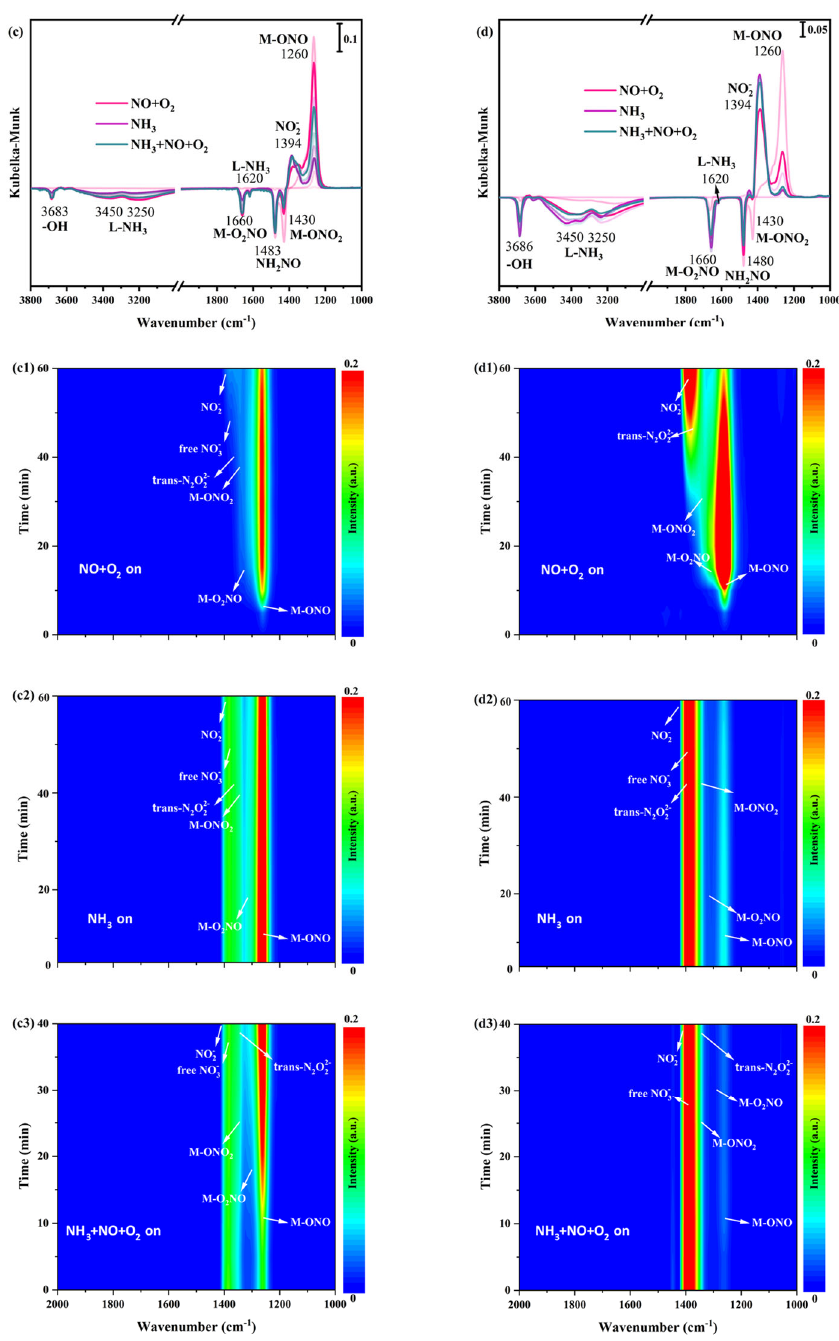
Figure 6. In situ DRIFTS spectra of NO+O 2 adsorption at 200 °C over ( a1 ) α -MnO 2 /X, ( b1 ) β -MnO 2 /X, ( c1 ) γ -MnO 2 /X, and ( d1 ) σ -MnO 2 /X catalysts; in situ DRIFTS spectra of NH 3 reacted with pre-ad- sorbed NO+O 2 species at 200 °C over ( a2 ) α -MnO 2 /X, ( b2 ) β -MnO 2 /X, ( c2 ) γ -MnO 2 /X, and ( d2 ) σ -MnO 2 /X catalysts; in situ DRIFTS spectra of NO+O 2 +NH 3 species at 200 °C over ( a3 ) α -MnO 2 /X, ( b3 ) β -MnO 2 /X, ( c3 ) γ -MnO 2 /X, and ( d3 ) σ -MnO 2 /X catalysts; the summary of in situ DRIFTS spectra of NO+O 2 adsorption, NH 3 reacted with pre-adsorbed NO+O 2 species, and NH 3 +NO+O 2 species at 200 °C over ( a ) α -MnO 2 /X, ( b ) β -MnO 2 /X, ( c ) γ -MnO 2 /X, and ( d ) σ -MnO 2 /X catalysts; conditions: 500 ppm NH 3 (when used), 500 ppm NO, 11% O 2 (when used), and N 2 as balance.